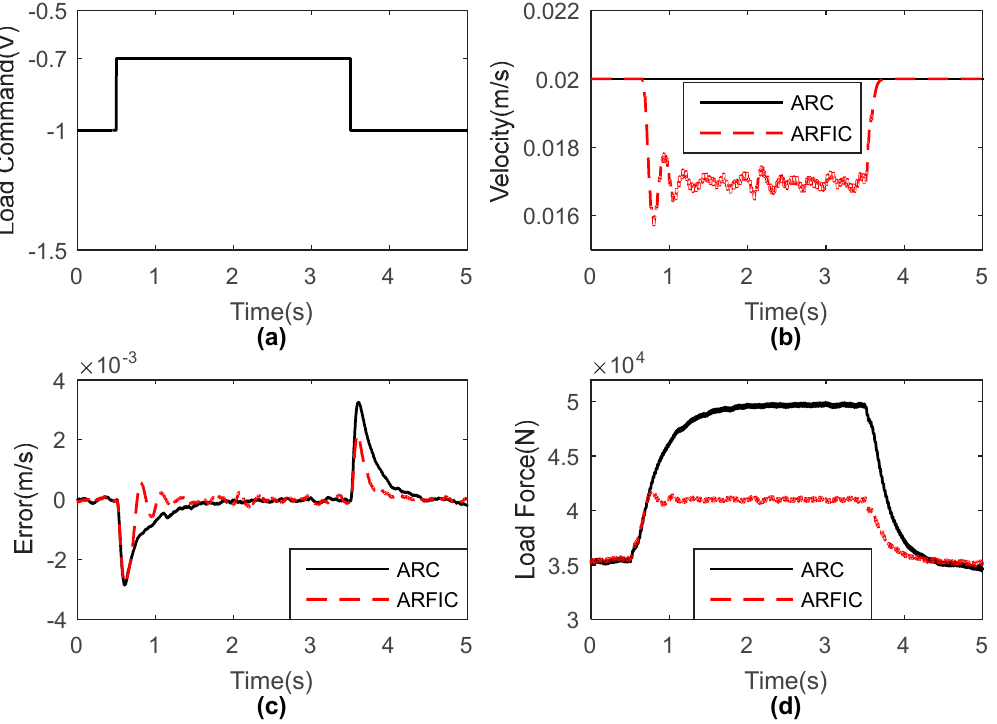
Figure 9. Tracking performance with a 0.02 m/s velocity command and − 1 V ∼ − 0.7 V ∼ − 1 V load command: ( a ) load command; ( b ) velocity commands; ( c ) velocity tracking errors; ( d ) load forces.